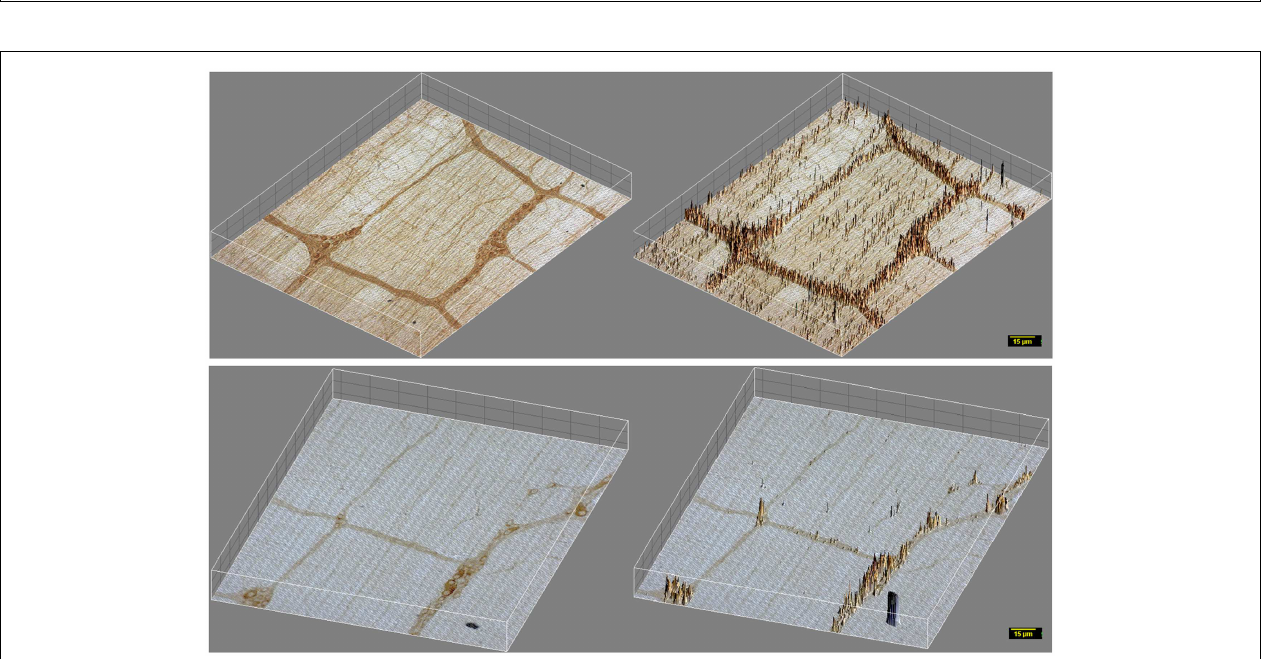
FIGURE 2 | MyosinVa immunoreactivity extending from the cell body to the processes of Dogiel type 2 neurons emanating from myenteric plexus . In vehicle treated group (left panel), myosinVa is present in the initial segment, as well as axonal processes extending to the muscle layers. MyosinVa is also present in the interneuronal processes within the